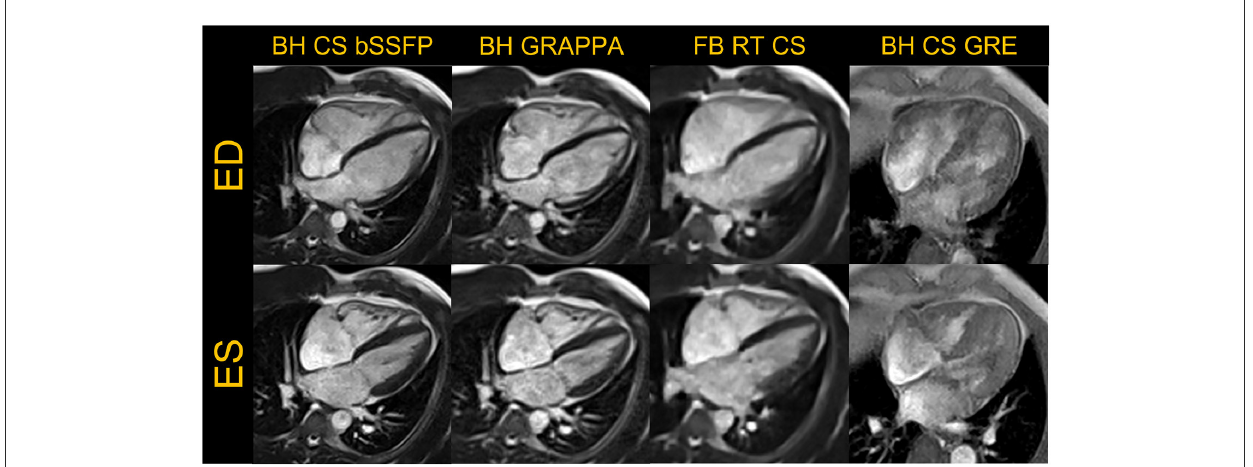
FIGURE1 Representative examples of images acquired in a four-chamber view are shown in the end-diastole (ED) and end-systole (ES) frames for breath-held (BH) compressed sensing (CS) and GRAPPA based segmented bSSFP cine, free-breathing (FB) real-time (RT) CS bSSFP cine and BH CS based GRE cine are shown. The GRE images were acquired in a different volunteer.